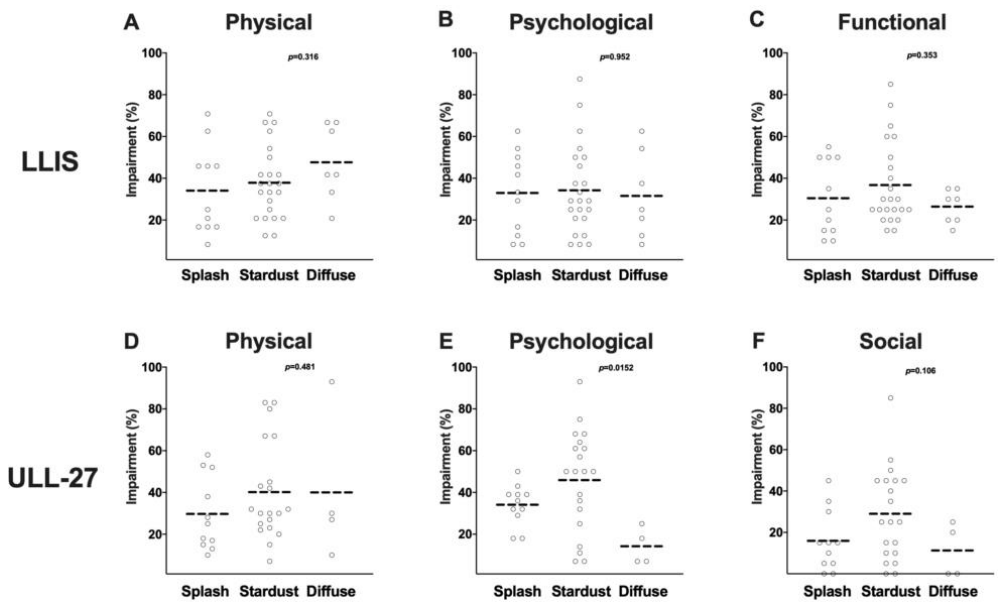
Figure 8. ( A ) Scatter plot of ICG stage vs. LLIS physical domain impairment score (%). ( B ) Scatter plot of ICG stage vs. LLIS psychological domain impairment score (%). ( C ) Scatter plot of ICG stage vs. LLIS functional domain impairment score (%). ( D ) Scatter plot of ICG stage vs. ULL-27 physical domain impairment score (%). ( E ) Scatter plot of ICG stage vs. ULL-27 psychological domain impairment score (%). ( F ) Scatter plot of ICG stage vs. ULL-27 social domain impairment score (%).